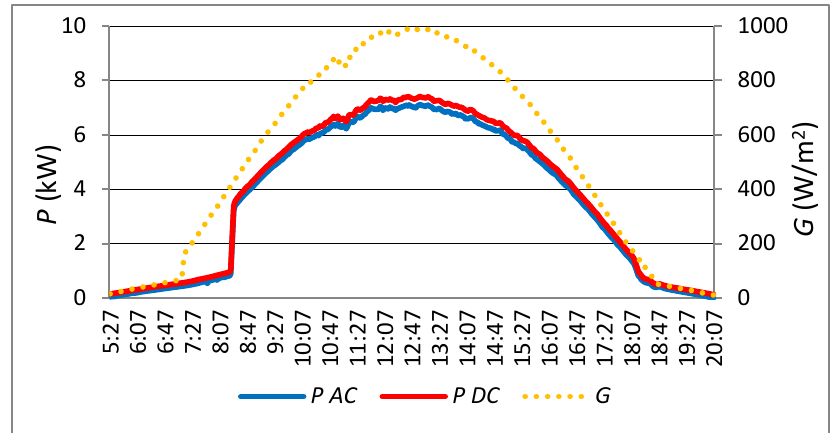
Figure 6. Irradiation G , input P DC and output power P AC variation during 7th of July 2015.